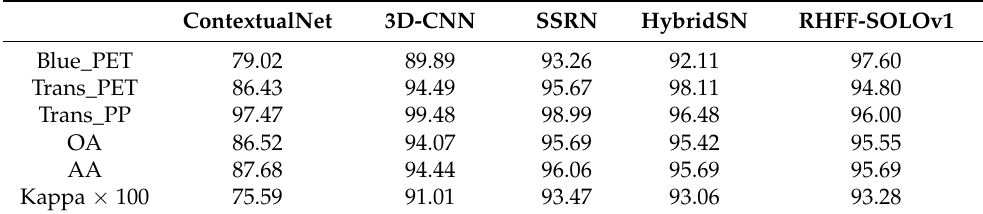
Table 4. Classification results between RHFF-SOLOv1 and other fusion